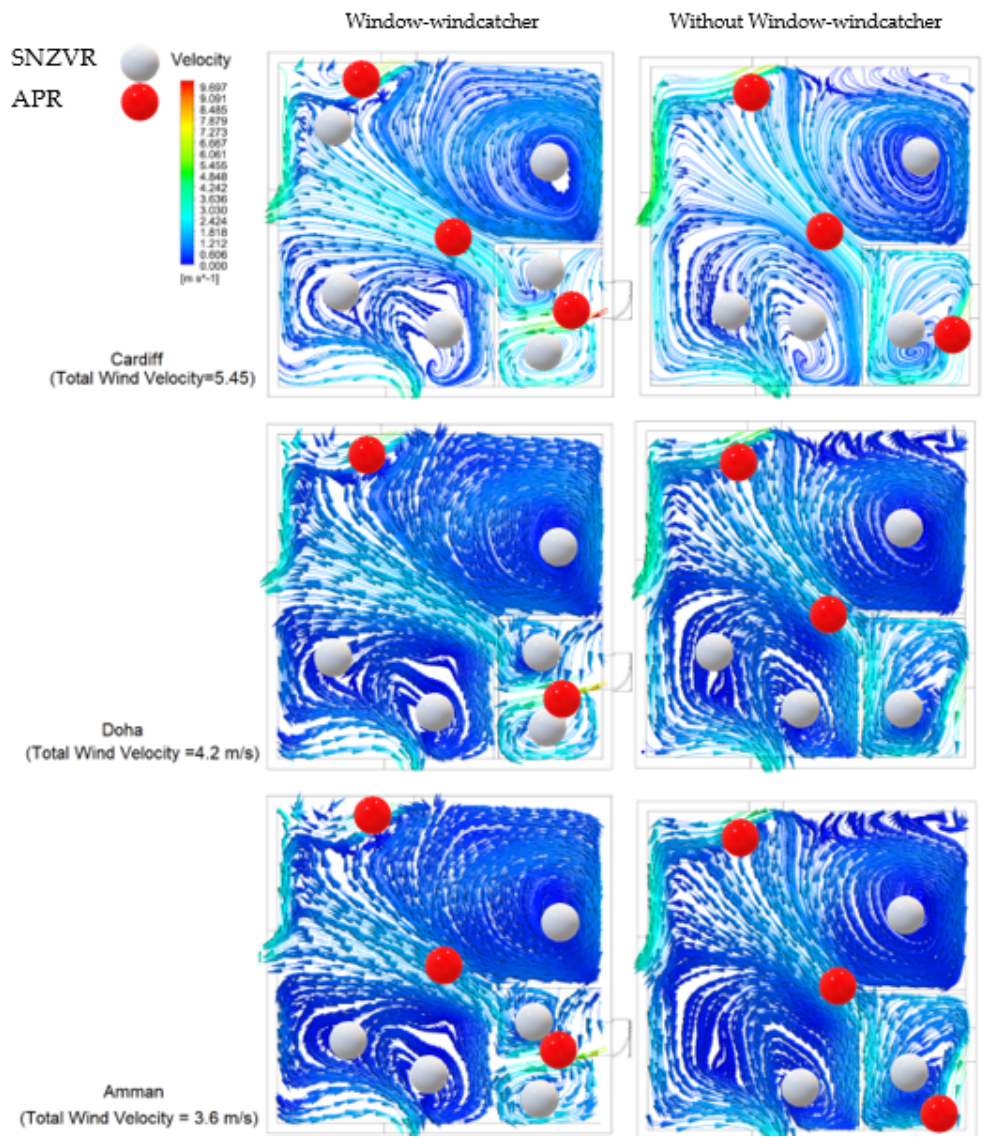
Figure 14. Streamlines at the 1.7 m interior plane (APR: Air purifiers region, SNZVR: safe near-zero- velocity regions).